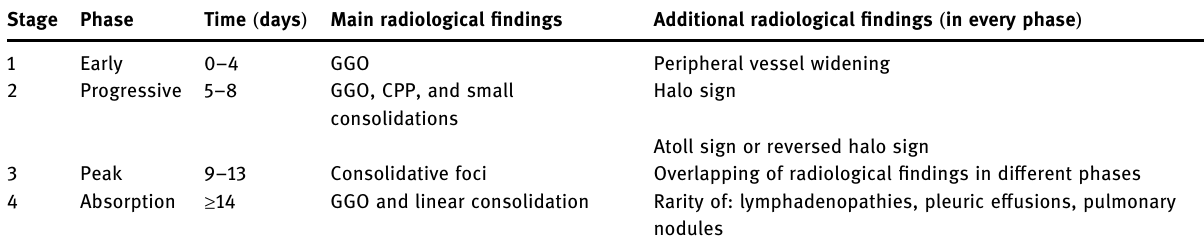
Table 1: Radiological fi ndings in COVID - 19 pneumonia Stage Phase